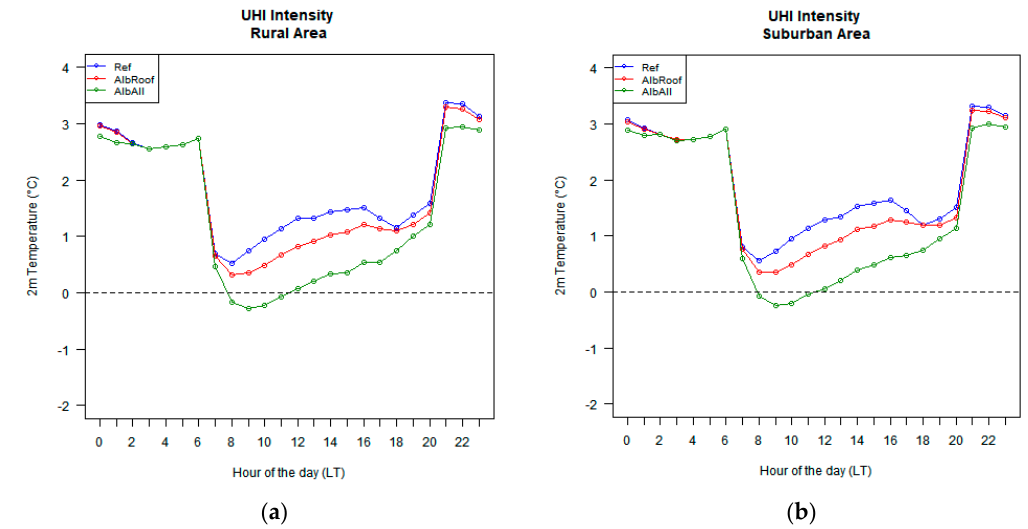
Figure 3. Daily cycles of UHI intensity (°C) averaged over the simulation period (14–23 July 2014) for the reference case (blue line), the test case with highly-reflective roofs coverage (AlbRoof, red line) and the test case with highly-reflective coverage for roofs, walls and roads (AlbAll, green line): ( a ) Average UHI intensity computed over the mixed forest land use (Rural) category in Figure 1; ( b ) Average UHI intensity computed over the croplands land use (Suburban) category in Figure 1.